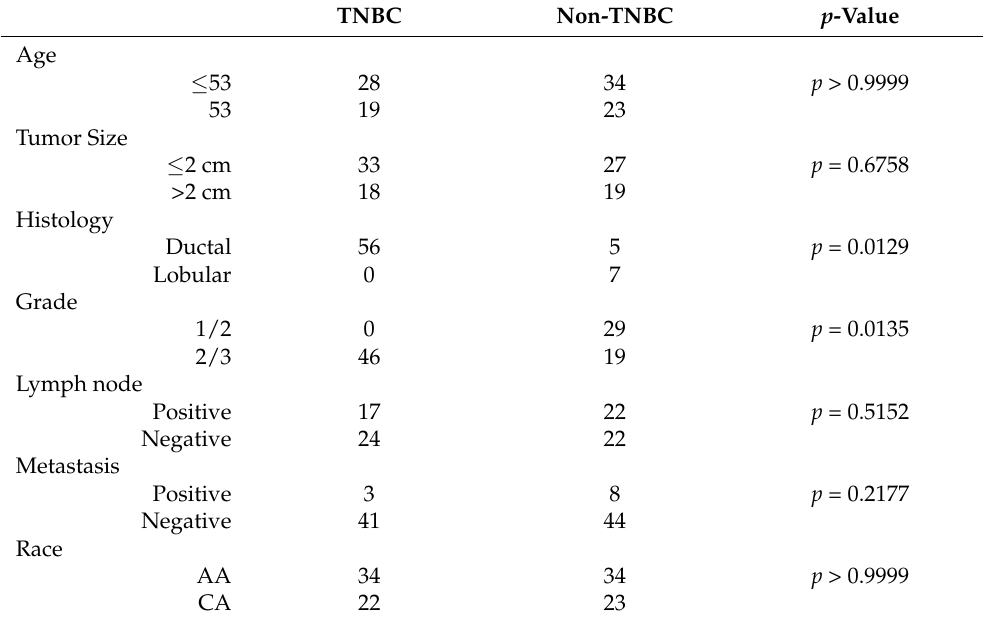
Table 1. Clinical and histopathological information of the breast cancer patients studied, distributed by the